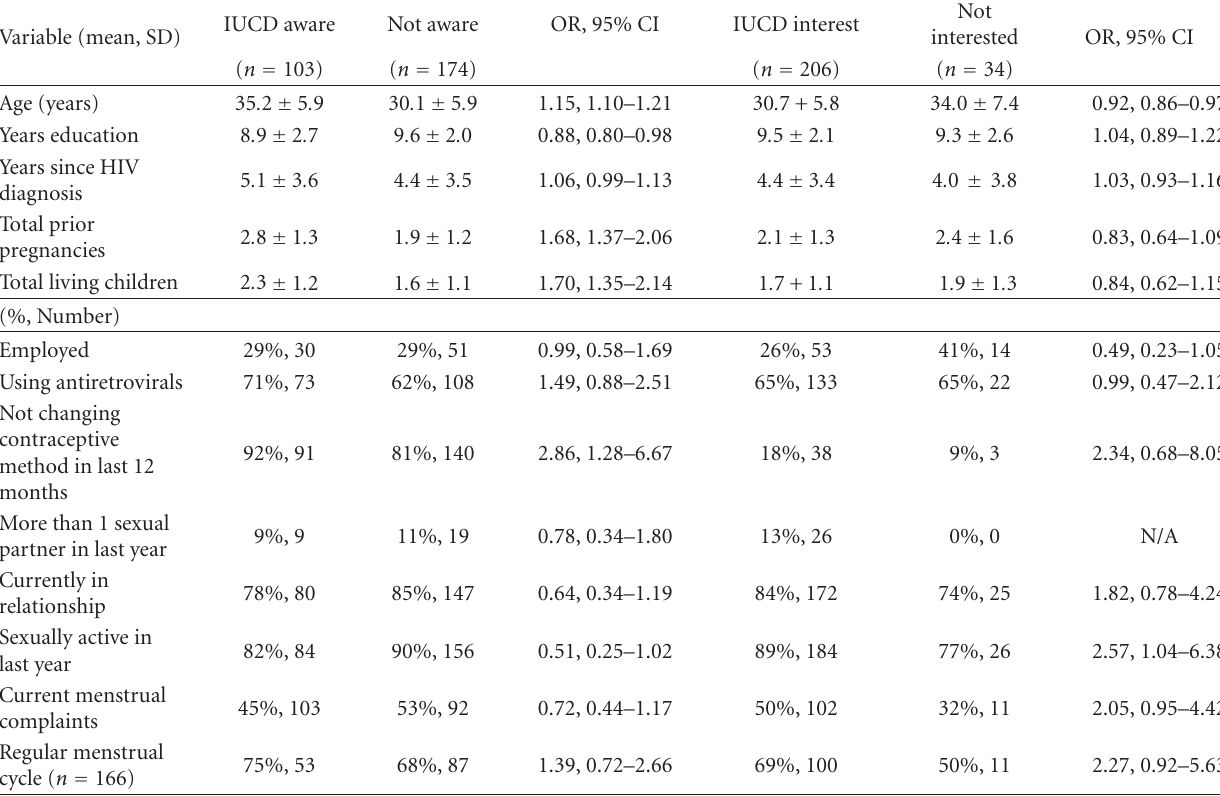
Table 3: Correlates of intrauterine contraceptive device (IUCD) awareness and interest in IUCD use among HIV-positive women in Cape Town, South Africa by univariable logistic regression